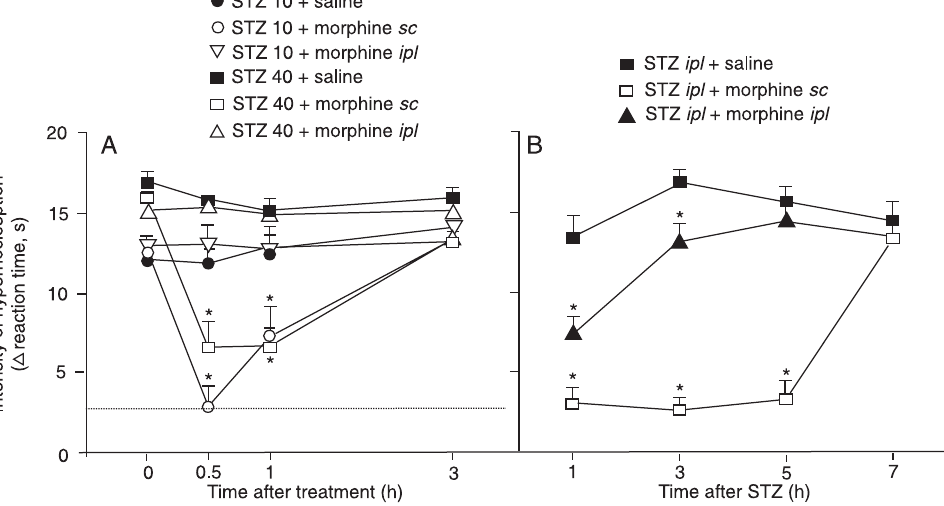
Figure 6. Effect of morphine on mechanical hypernociception induced by streptozotocin (STZ). Panel A, Saline (control groups, equivalent volume) or morphine (2 mg/kg, sc or 8 μ g/paw, ipl) was injected 31 days after STZ treatment (10 or 40 mg/kg). Mechanical hypernociception was measured before the treatments (time 0 h) and 0.5, 1, and 3 h later. The dotted line indicates the mean reaction time of citrate buffer-treated rats. Panel B, Saline (control group, equivalent volume) or morphine (2 mg/kg, sc; 8 μ g/paw, ipl) was injected 30 min before STZ treatment (100 μ g/paw). Mechanical hypernociception was evaluated 1, 3, 5, and 7 h after STZ injection. Data are reported as means ± SEM for groups of 6 rats. *P < 0.05 compared to saline-treated rats (ANOVA followed by the Bonferroni